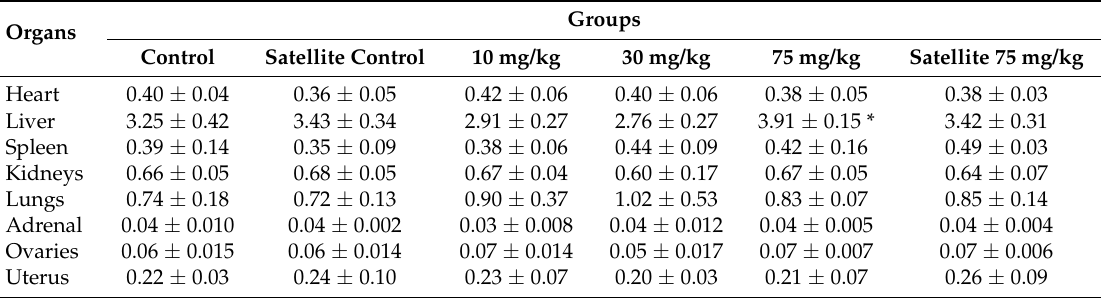
Table 2. Relative organ weights of female rats treated with different doses of the film formulation for 28 days.